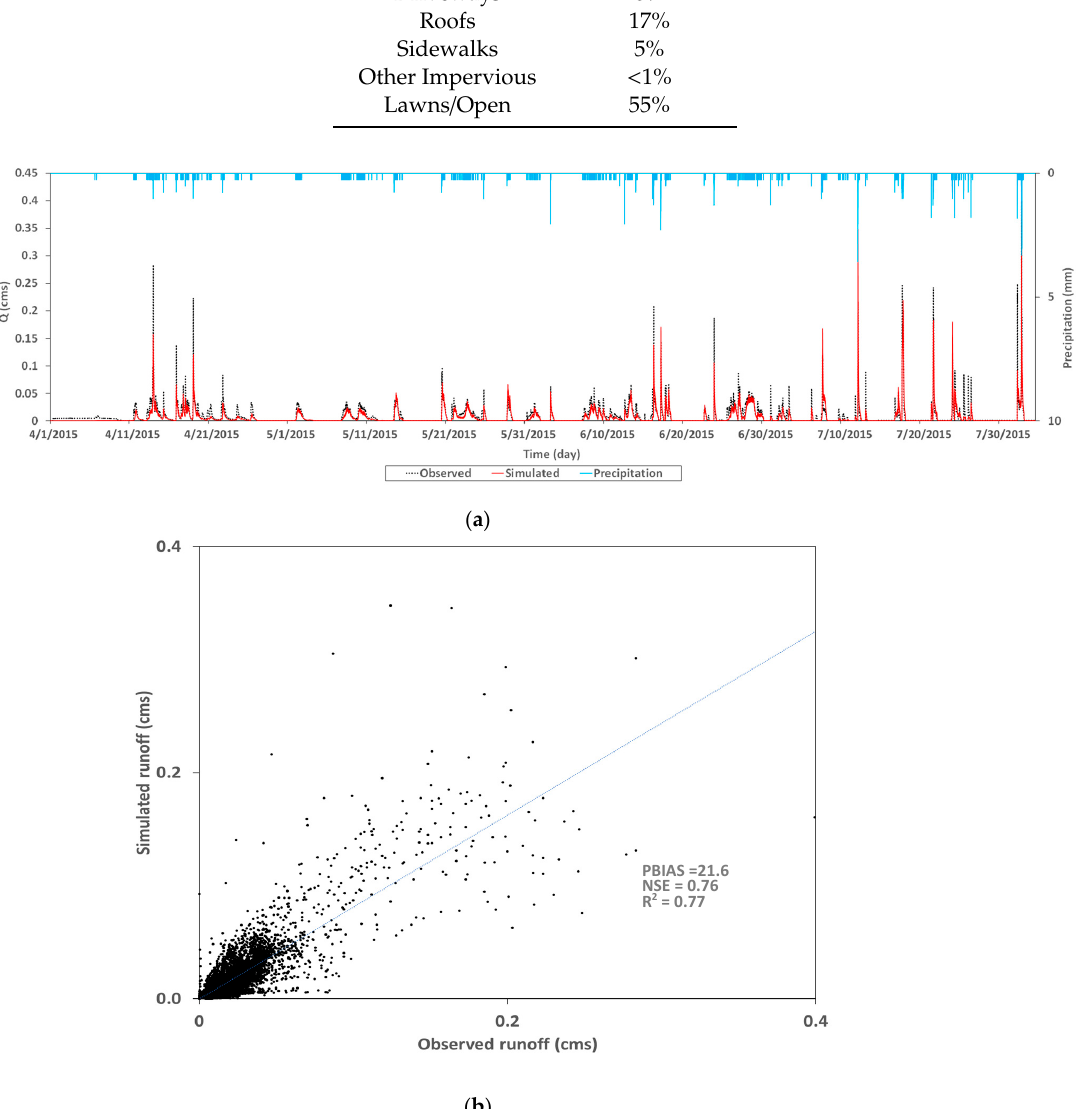
Figure 10. ( a ) Comparison of observed and simulated runoff for Yellowstone Drive catchment ( b ) Scatter diagram of observed and simulated data.